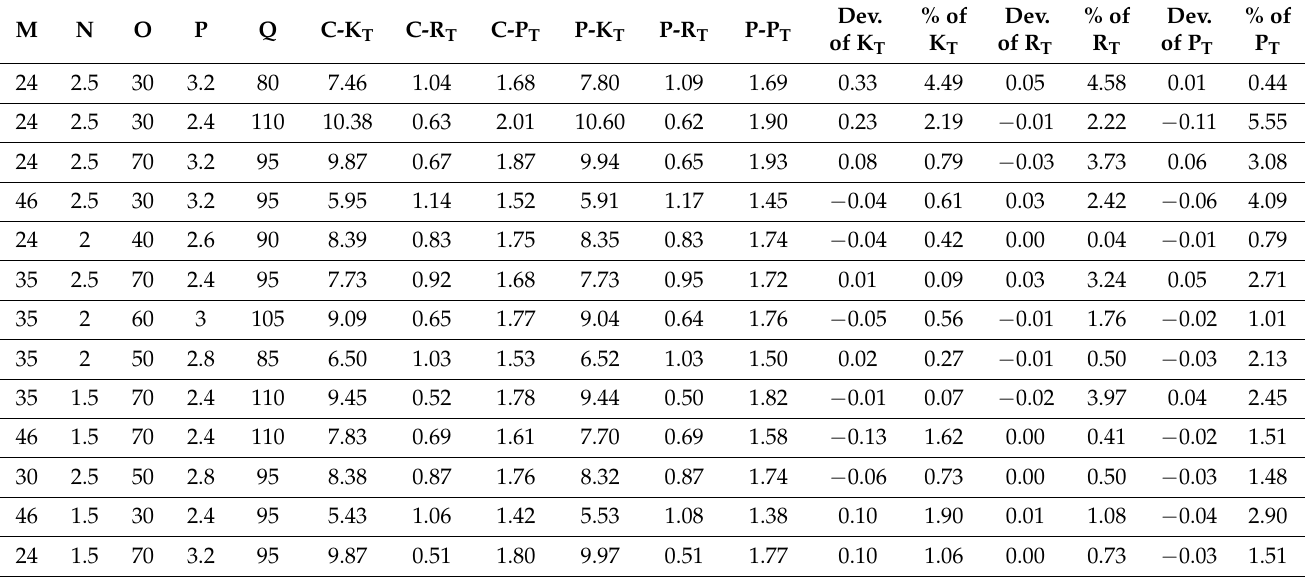
Table 10. Testing and comparing the prediction and calculation results for the TIG welding